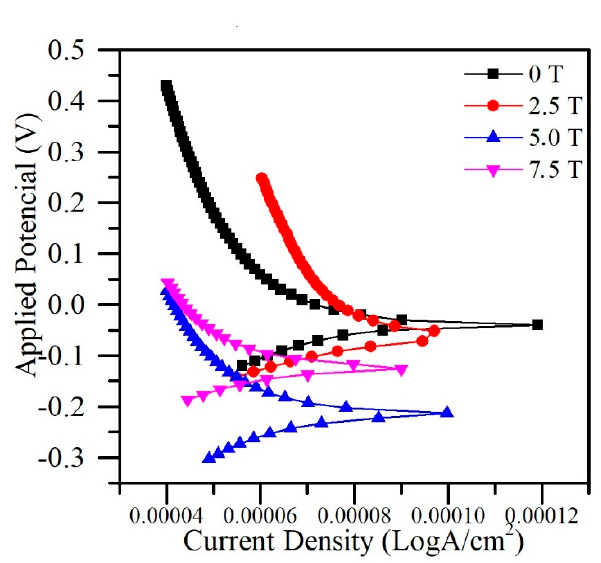
Figure 12. Current density versus the applied potential to the addition of the external magnetic field.